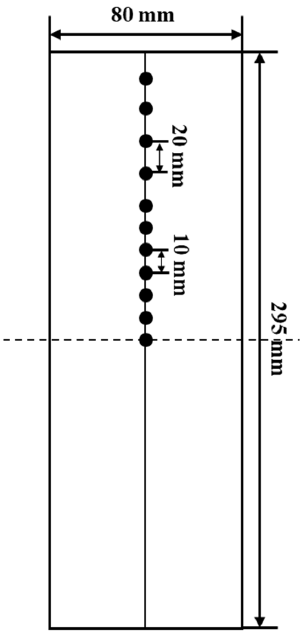
Figure 17. Carbon segregation sampling schematic.